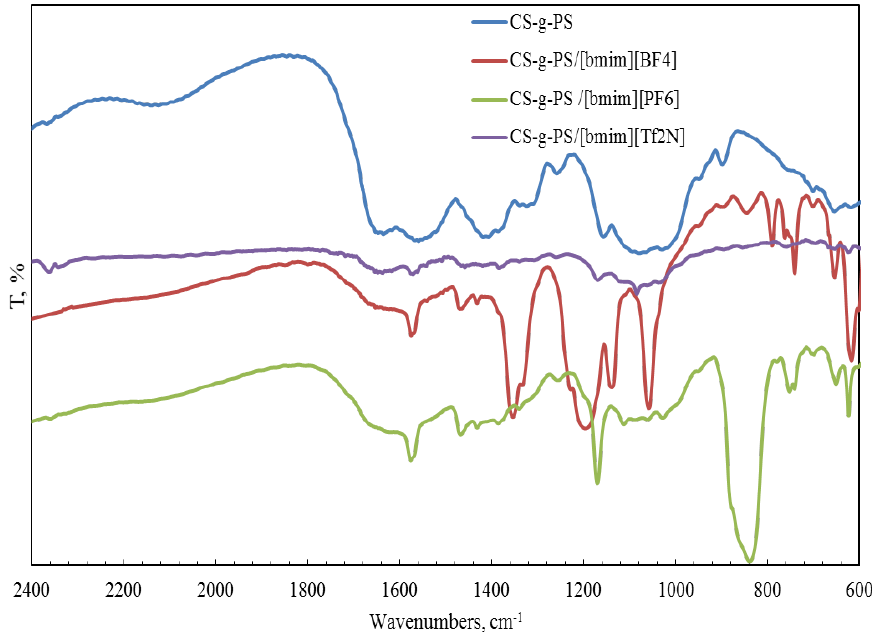
Figure 5. FTIR spectra of pure CS-g-PS copolymer and CS-g-PS copolymers doped with IL.